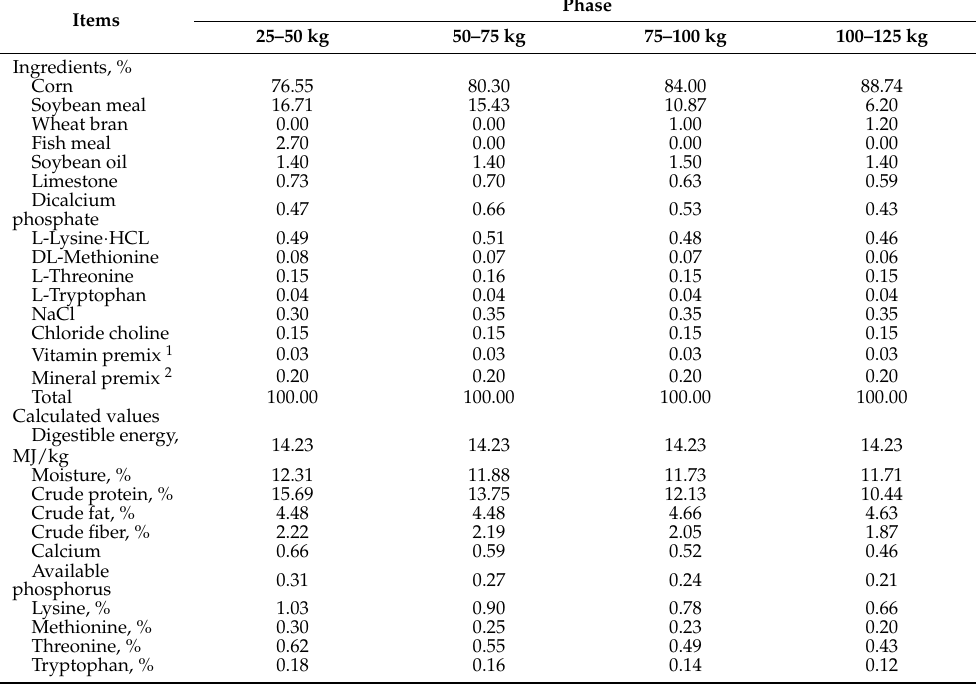
Table 1. Composition and nutrients levels of basal diet (air dry basis, %).